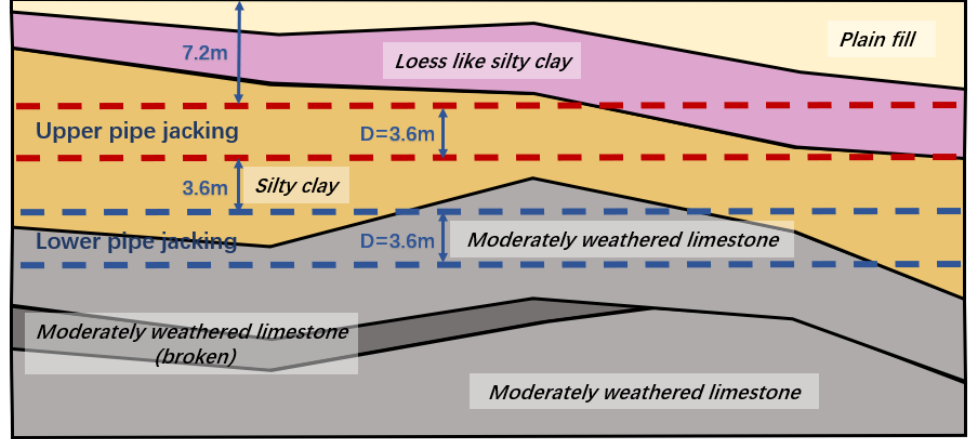
Figure 2. Geological cross section of vertical double pipe jacking tunnel.